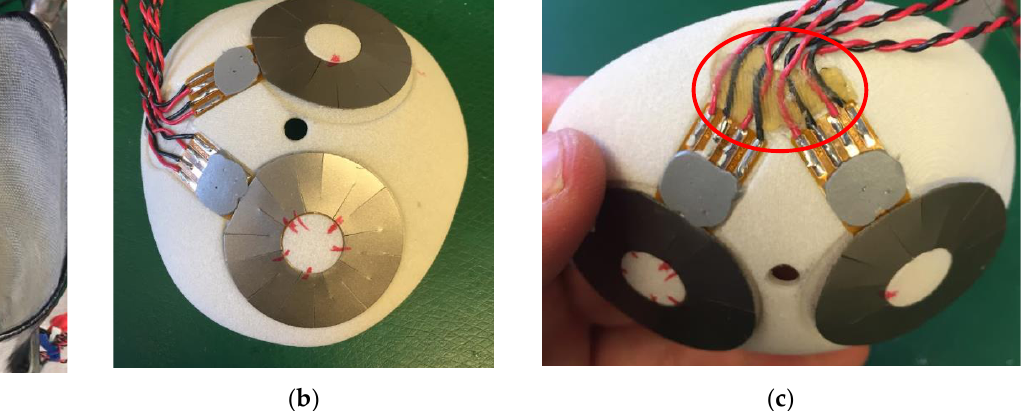
Figure 3. Insert assembly and placement into a socket. ( a ) Marks are inked on the insert and socket during a dry run assembly to facilitate proper alignment. ( b ) Antennae are affixed to the insert using hot melt, and annular-shaped Ferrite disks are affixed using double-sided tape. ( c ) Leadwires are covered with hot melt.